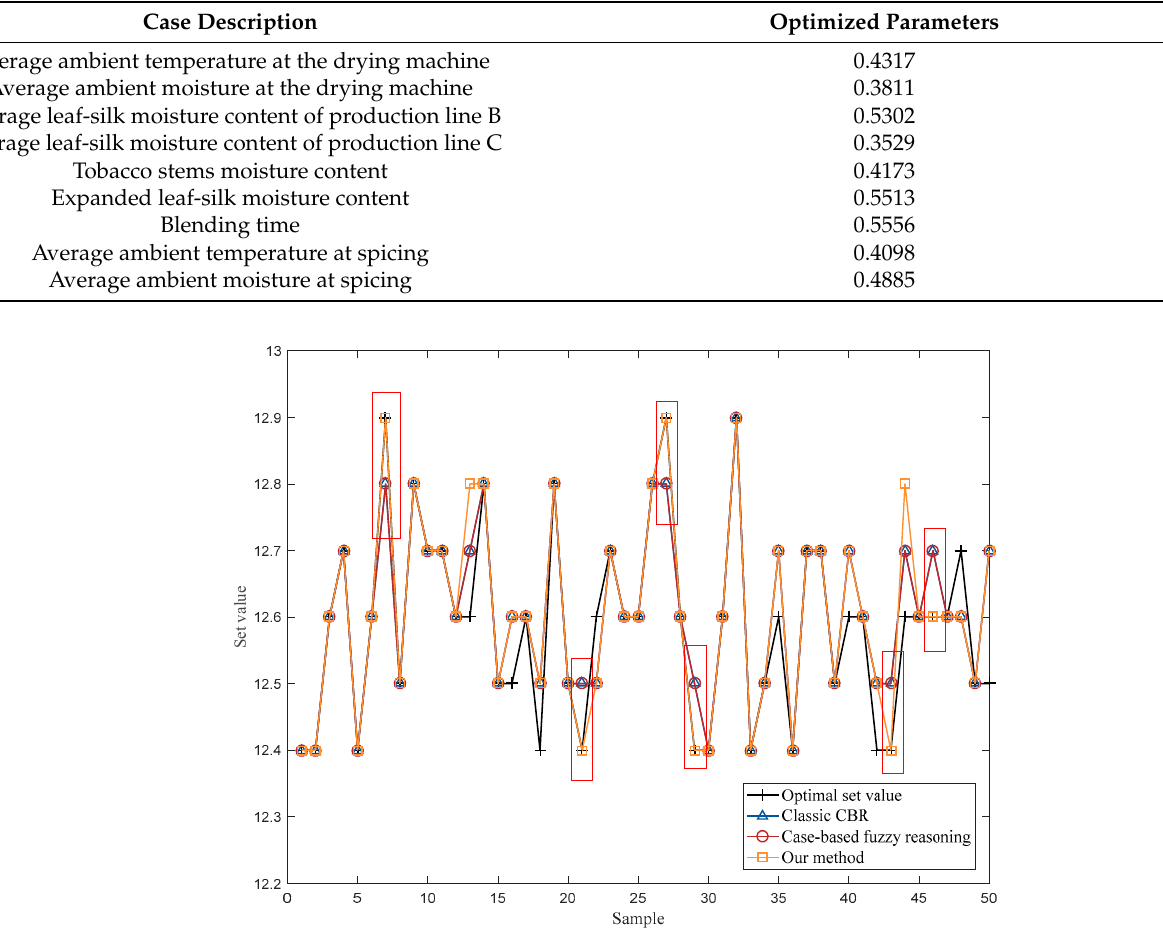
Figure 6. Set values of the testing dataset for industrial cut-made process.